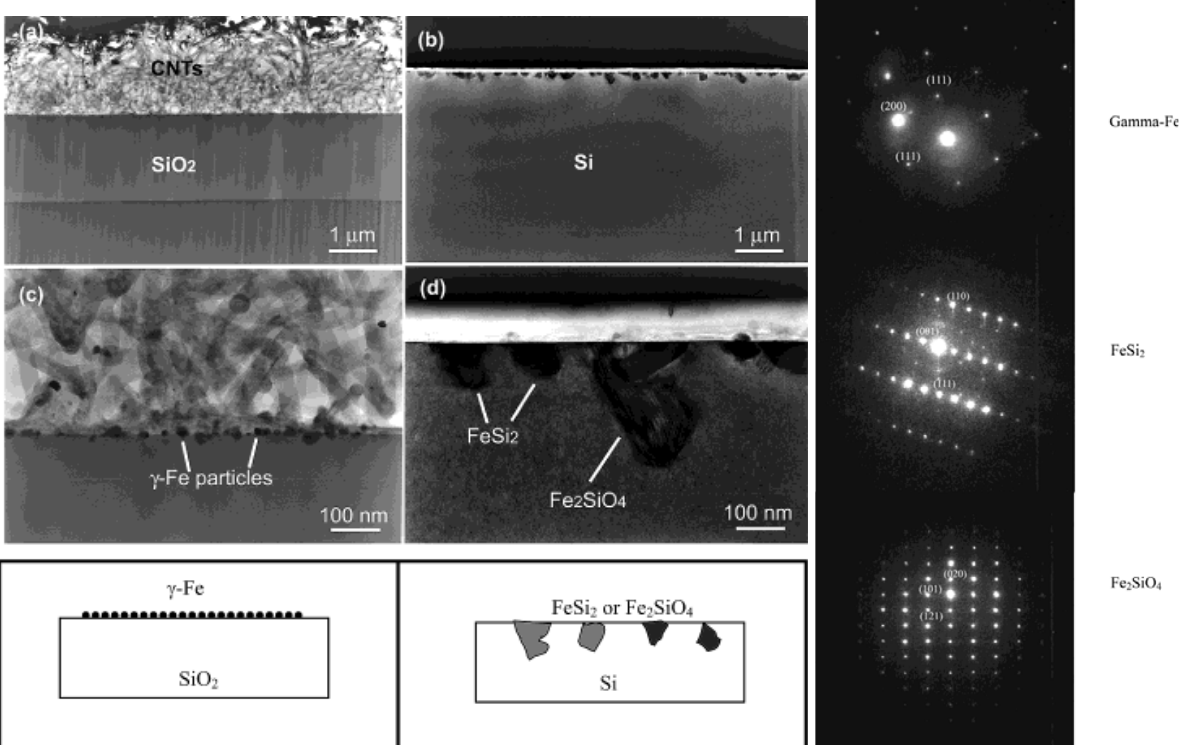
Figure 15. TEM images of the cross section of the substrates. (Left) (a) SiO CVD growth and removing of carbon nanotubes. (b) Si area without any nanotube growth but precipitate of submicron-size particles near the surface. (c) Enlarged picture from the nanotube/SiO interface in (a) showing the formation of gamma iron particles on silicon 2 oxide surface and the growth of nanotubes from the particles formed. (d) Enlarged area from (b) showing the formation of iron silicide and iron silicate crystals during CVD processing. Corresponding schematics are also illustrated. (Right) The panels on the right hand side depicts, selective area diffraction patterns from the particles on the oxide surface (c) and on the Si surface (d), indicating gamma iron (fcc-Fe) formation and iron silicide and iron silicate formation during the CVD process on silicon oxide surface and silicon surface, respectively. Reproduced from Ref. [96] with permission from American Chemical